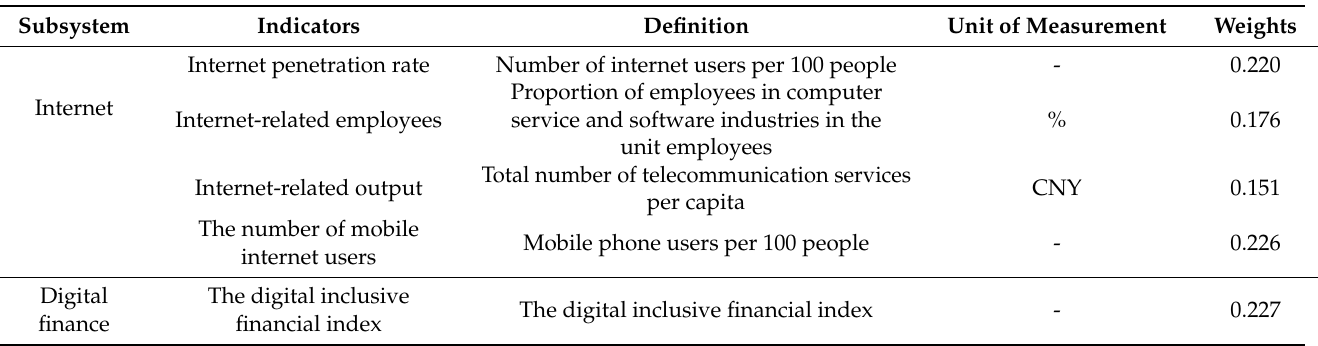
Table 2. Digital economy comprehensive index